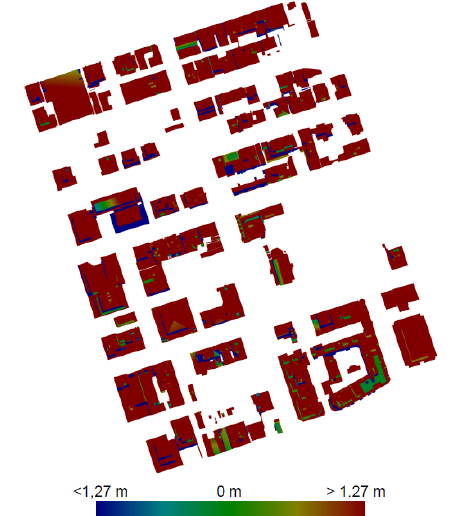
Fig. 17. Height difference between the reference DSM and the generated results for Area